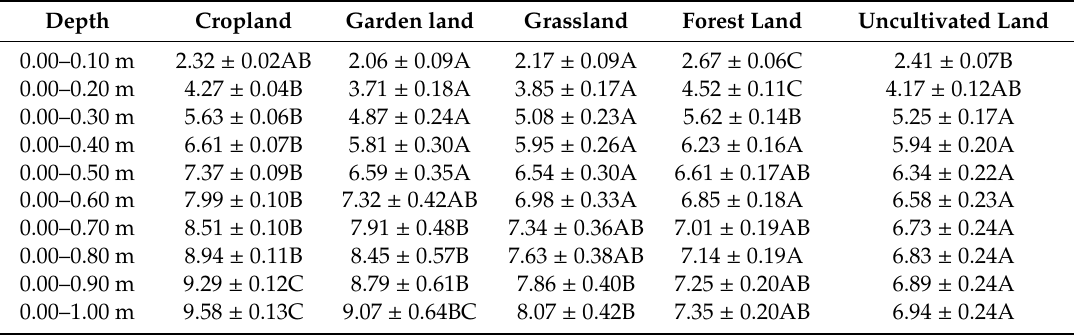
Table 3. Profile characteristics of soil bulk density from di ff erent land uses ( × 10 3 kg m − 3 ) Soil Layers